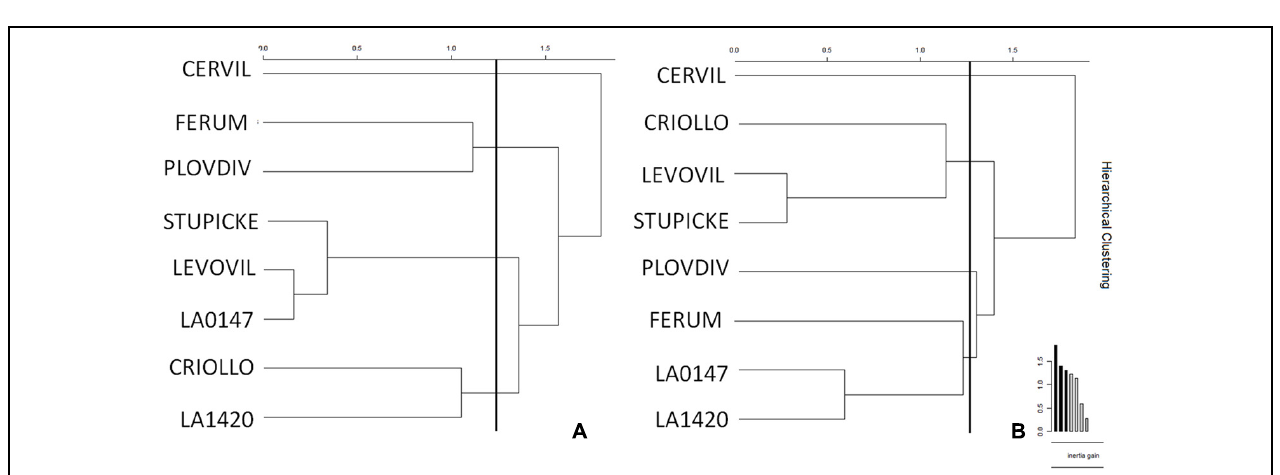
FIGURE 5 | Clustering of genotypes according to the AUCs for leaf and fruit traits for (A) control and (B) WD plants. AUCs were calculated according to the trapezoidal rule for each variable measured at the end of each WD or RP (except RP3 which was not included in the area because of leaf senescence). AUCs are the integrals of the parameters over time computed for control and WD plants. The WD treatments consisted in three WD of increasing intensity followed by RPs. Clusters were realized depending on Euclidean distances (vertical bars in the graph) and inertia